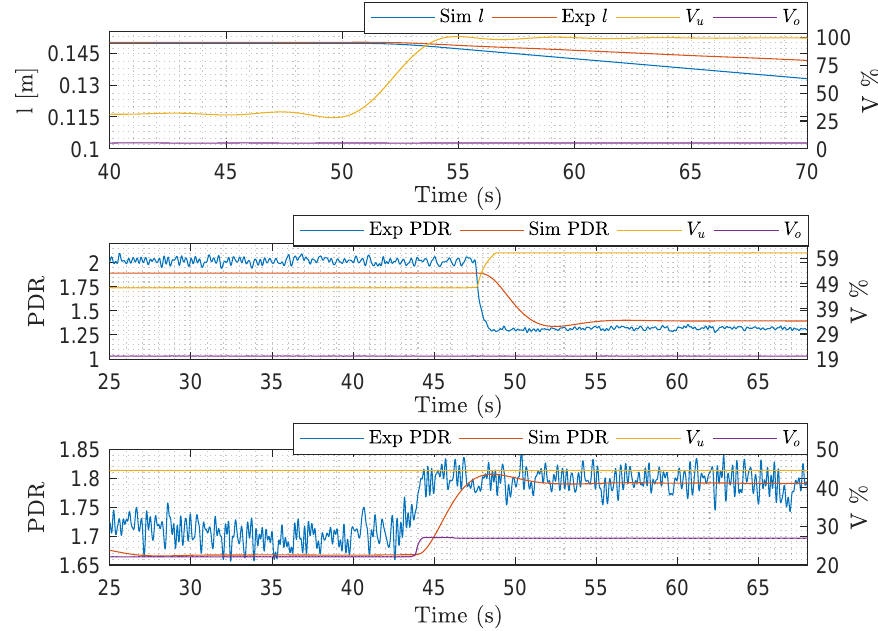
Figure 3. Step response validation of the model, with respect to the gravity separator and the